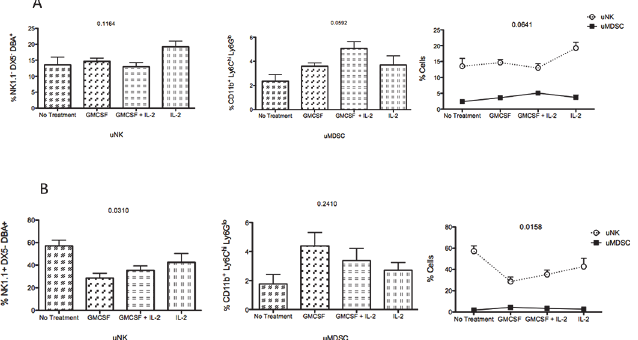
Fig 7. Effect of GM-CSF on the uNK cells and uMDSC from pregnant mice. A. CBA/CaJ female mice were mated with C57BL/6 allogeneic male mice. Uterine NK cells were flow sorted to obtain a NK1.1 - DX5 - DBA + cell population that was incubated with GMCSF (20ng/ml) ± IL-2 (20ng/ml) for 5 – 7 days. Expression of uNK and CD11b + Ly6G hi Ly6C lo and CD11b + Ly6G lo Ly6C hi cell populations were analyzed using a flow cytometer. GMCSF treatment resulted in no significant change in the NK1.1 - DX5 - DBA + cell population from the CBA mice (p = 0.1164). However, an increase of the CD11b + Ly6G lo Ly6C hi population was observed (p = 0.0592). An inverse correlation was observed between the uNK cells and uMDSC in presence of both GMCSF and IL-2 treatment but was not statistically significant. B. C57BL/6 female mice were mated with allogeneic CBA/CaJ male mice. Uterine NK cells were flow sorted to obtain a NK1.1 + DX5 - DBA + cell population that was incubated with GMCSF (20ng/ml) ± IL-2 (20ng/ml) for 5 – 7 days. Expression of uNK and CD11b + Ly6G hi Ly6C lo and CD11b + Ly6G lo Ly6C hi cell populations were analyzed using a flow cytometer. GMCSF treatment resulted in a significant change in the NK1.1 + DX5 - DBA + cell population from the C57BL/6 female mice (p = 0.0310). However, the change in the CD11b + Ly6G lo Ly6C hi population was not significant (p = 0.2410). The effect of GMCSF was more pronounced in the uNK cells from the C57BL/6 female mice and a significant inverse correlation between uNK and uMDSC was also observed (p = 0.0158). Data are presented as mean ± SEM and are representative of at least 3 experiments. Statistical analysis was done by one-way analysis of variance (ANOVA) using Kruskal-Wallis test and two way